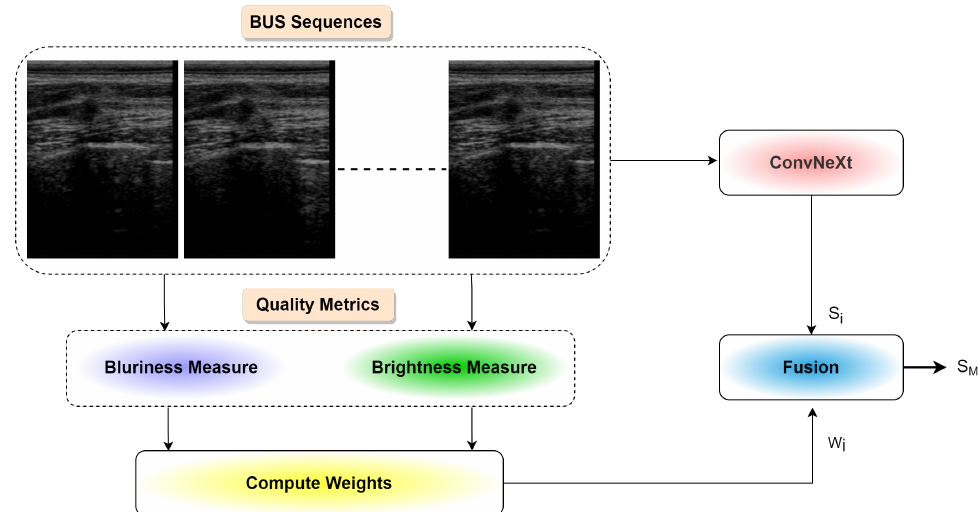
Figure 6. Schematic diagram of malignancy score pooling